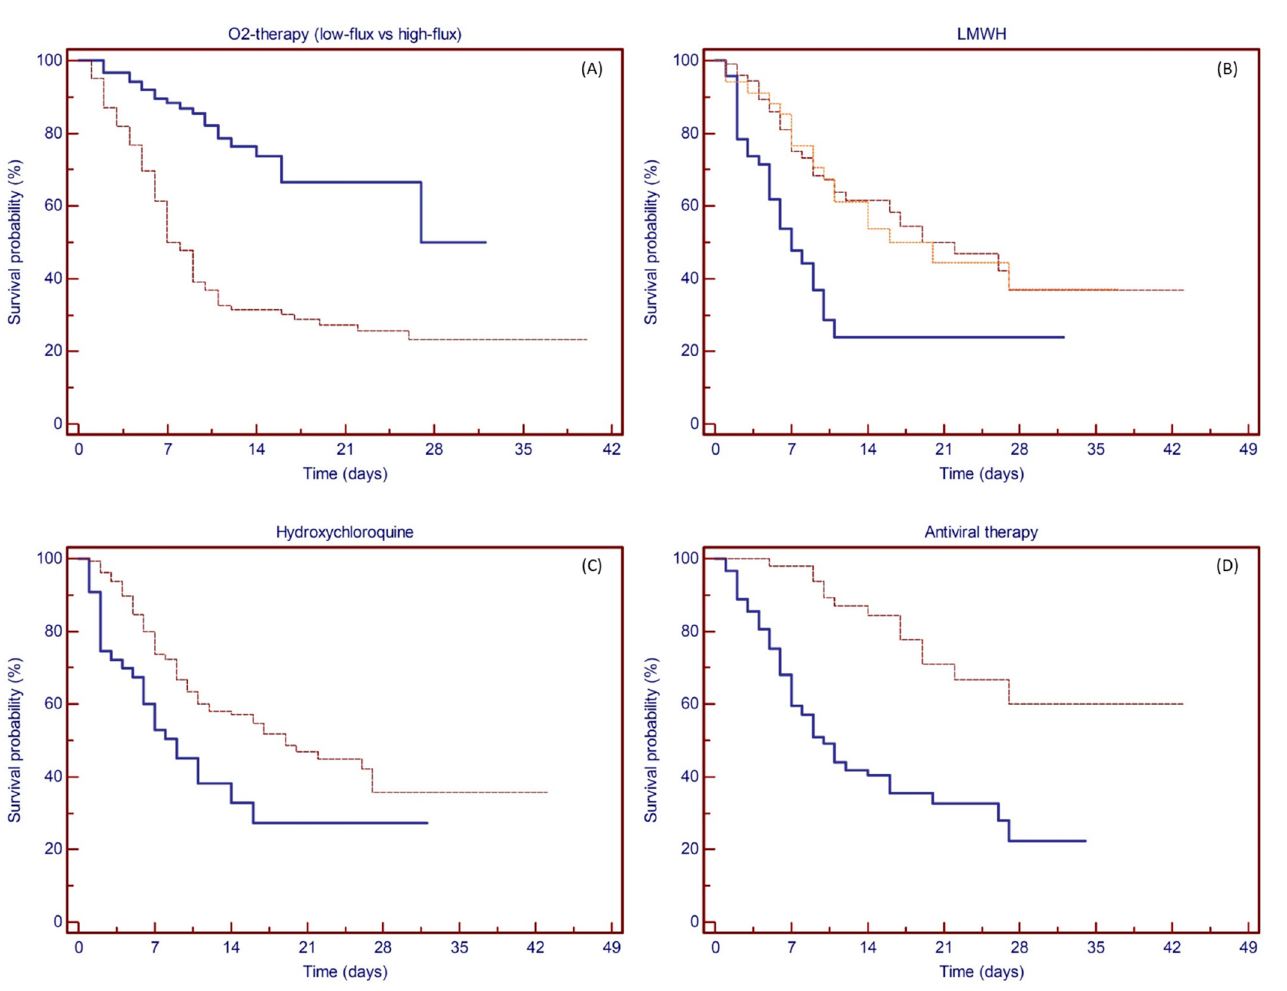
Figure 4. Kaplan–Meier plots showing the probability of survival based on treatments. ( A ) Patients treated with low-flux (solid line) or high-flux (dashed line) oxygen therapy. O2 therapy showed prognostic significance for survival ( p < 0.0001), with an estimated 28-day survival rate of 50.0% and 23.3%, respectively. ( B ) No anticoagulation therapy (solid line) vs. LMWH at prophylaxis dose (dashed line) or therapeutic dose (dotted line). LMWH treatment showed prognostic signifi- cance for survival ( p = 0.0001), with an estimated 28-day survival rate of 23.8%, 36.9%, and 37.1%, respectively. ( C ) No